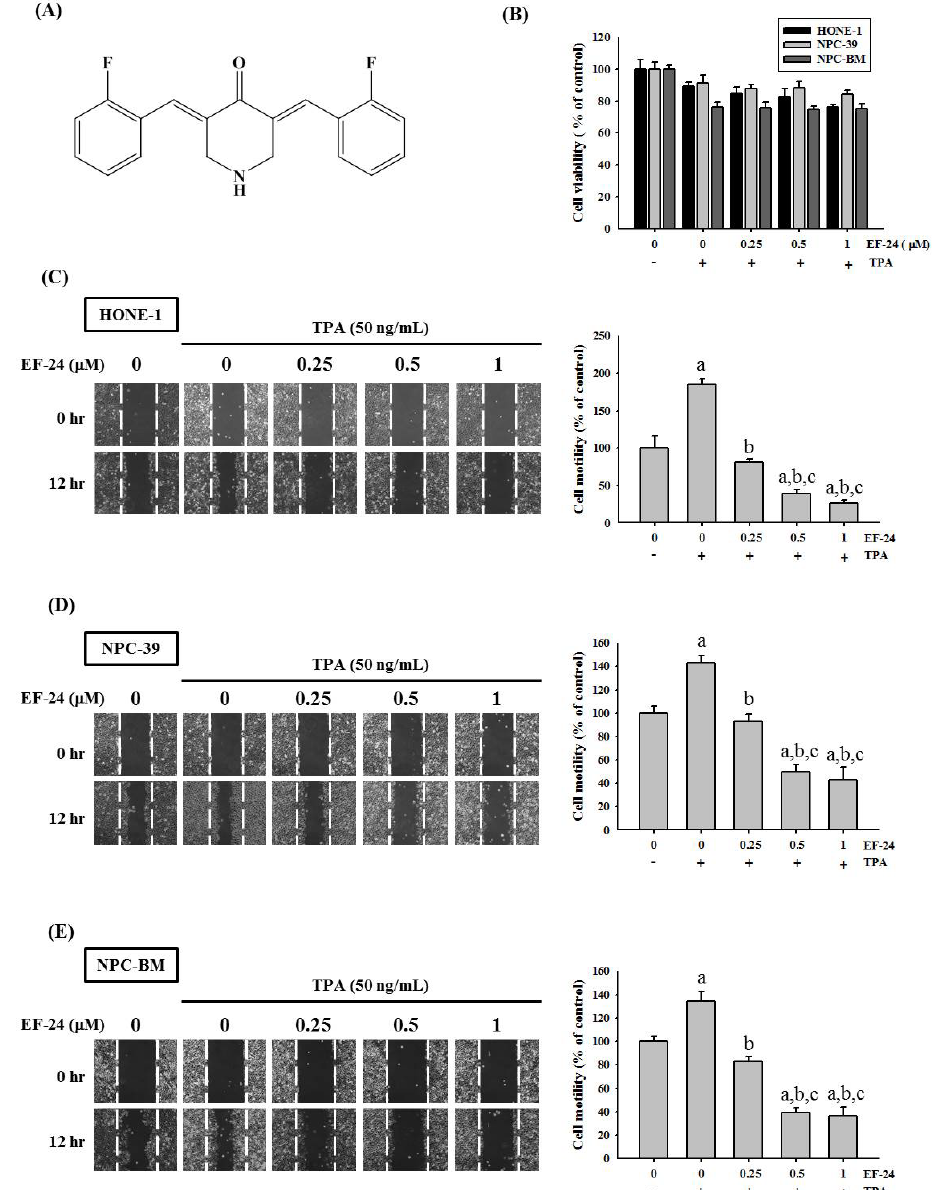
Figure 1. EF-24 inhibited TPA-induced cell motility but did not render cytotoxicity in human NPC cells. ( A ) Structural formula of EF-24. ( B ) Prior to examining for cell viability, NPC cell lines were incubated with different concentrations of EF-24 for 1 h and then treated with TPA for an additional 23 h. Data represented the means ± SD from at least three separate experiments. ( C – E ) Wound closure of HONE-1 ( C ), NPC-39 ( D ), or NPC-BM cells ( E ) was assessed by measuring the width of the remaining wound area relative to the original wound width at 12 h post-treatment of EF-24 and TPA. Data represented the means ± SD from at least three independent experiments. a Significantly different, p < 0.05, when compared with the control group. b Significantly different, p < 0.05, when compared with the TPA treatment group. c Significantly different, p < 0.05, when compared with the TPA treatment plus EF-24 (0.25 µ M)